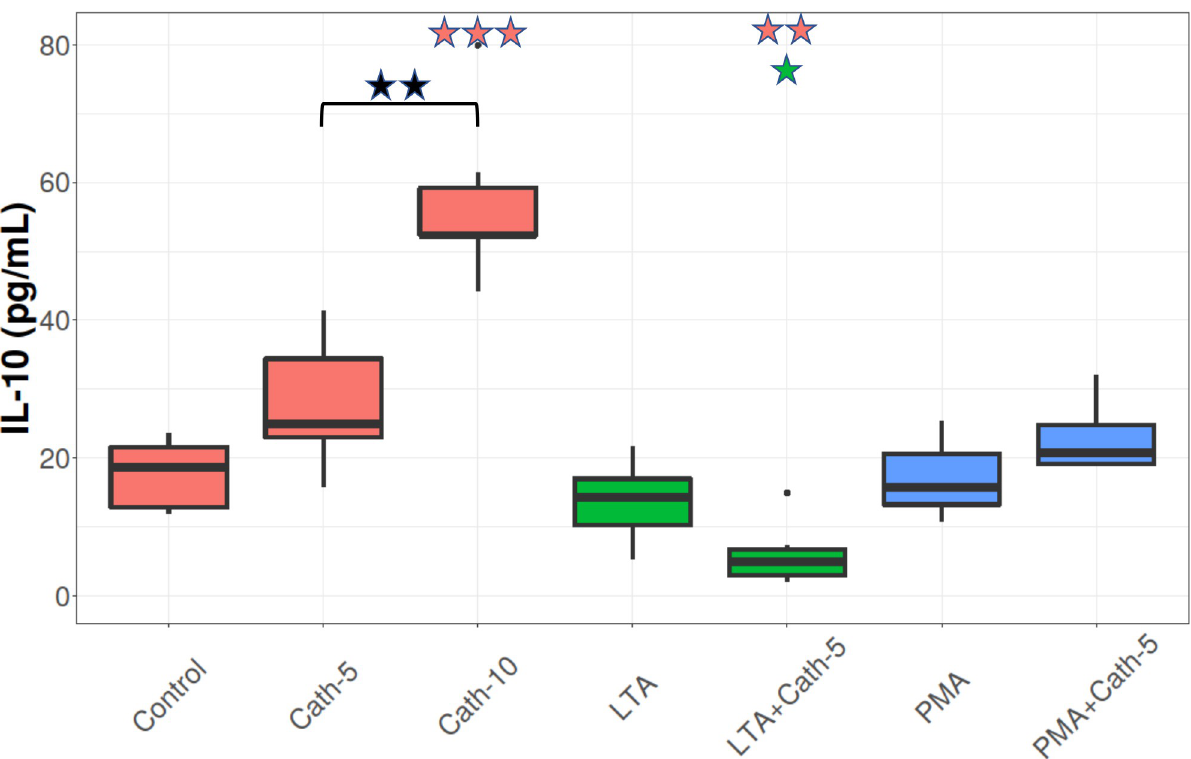
Fig 5. IL-10 concentration. Boxplots showing the interleukin-10 (IL-10) concentration for hepatocyte—non-parenchymal cell co-cultures treated with chicken cathelicidin-2 (Cath), lipoteichoic acid (LTA), or phorbol myristate acetate (PMA) only, or the combination of Cath and LTA or PMA (n = 6/group). Results are displayed as pg/mL Cath-5 = 5 nmol/mL Cath, Cath-10 = 10 nmol/mL Cath, LTA = 50 μ g/mL Staphylococcus aureus LTA, PMA = 1000 ng/mL PMA. The Control refers to absolute control cells that received none of the treatments. Red asterisks over the boxes refer to significant differences compared to control cells, green asterisks to the group treated only with LTA, blue asterisks to the group treated only with PMA, and black asterisks between the two concentrations of Cath. � p < 0.05, �� p < 0.01, ��� p < 0.001.